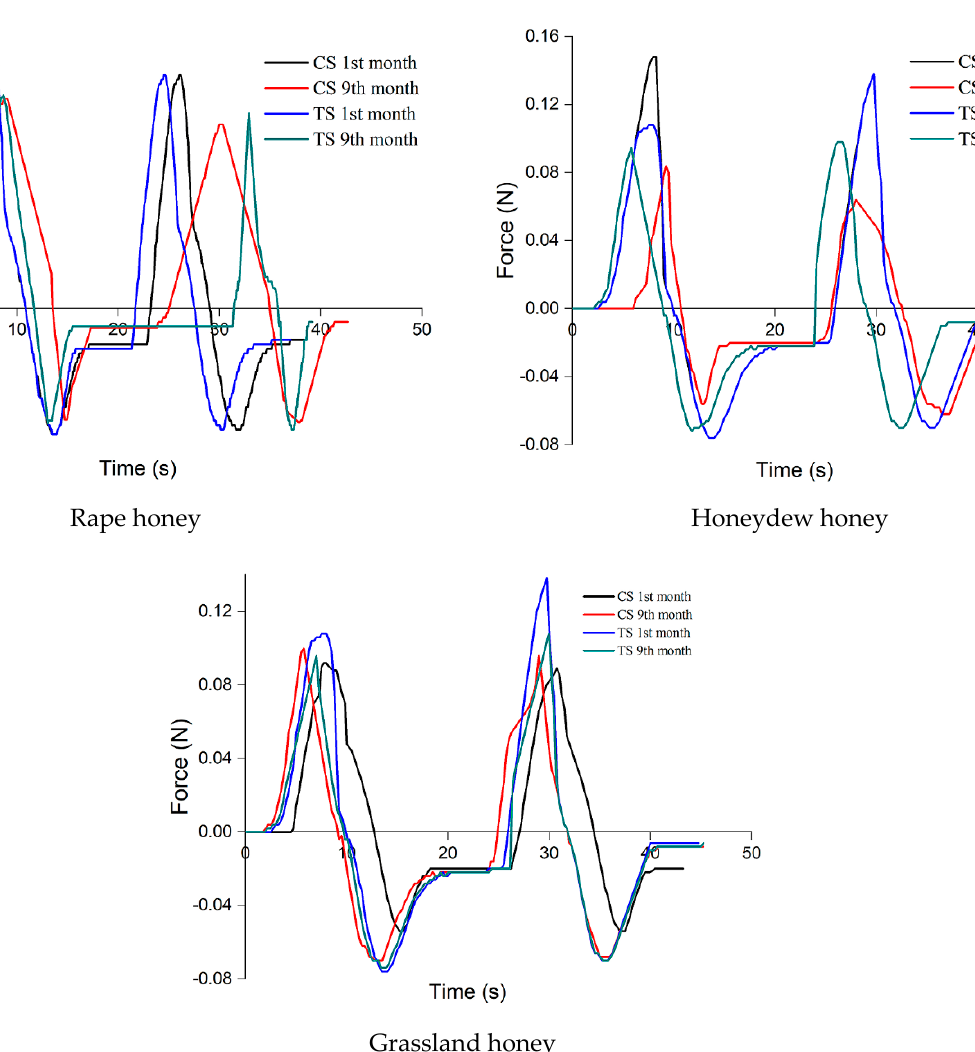
Figure 2. Texture analysis for the seven honey samples (CS: control samples, TS: treated samples).